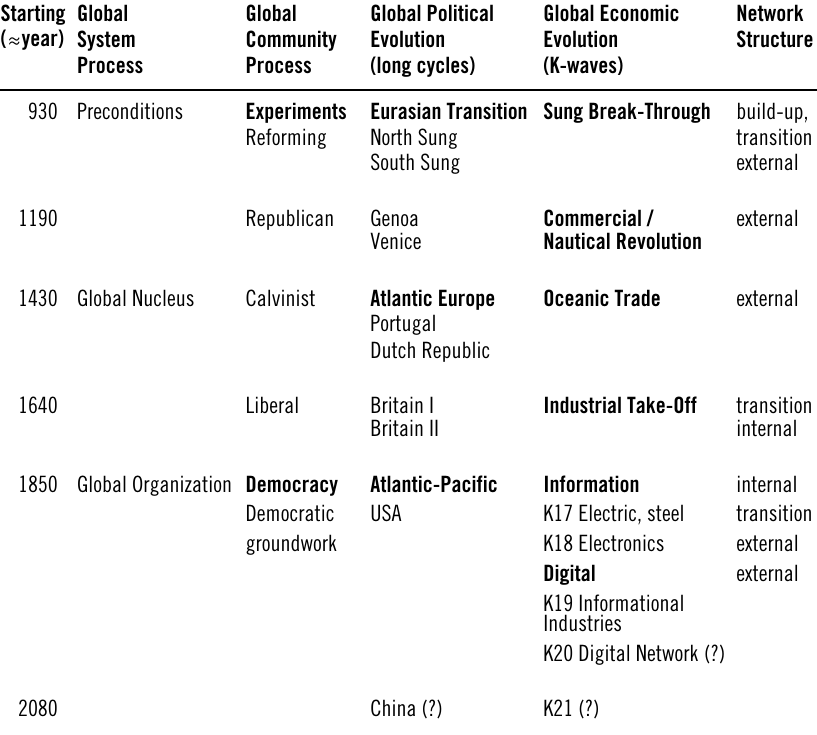
Table 1 – Evolutionary Global System Process Model, 930 CE–2080